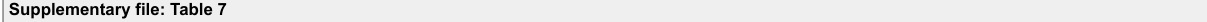
Supplementary file: Table 7 Adjusted OR's* for doctor's visit per 10 µg/m 3 increase in TSP at separate lags in major subcategories of participants after stratification by gender as estimated in conditional logistic regression.